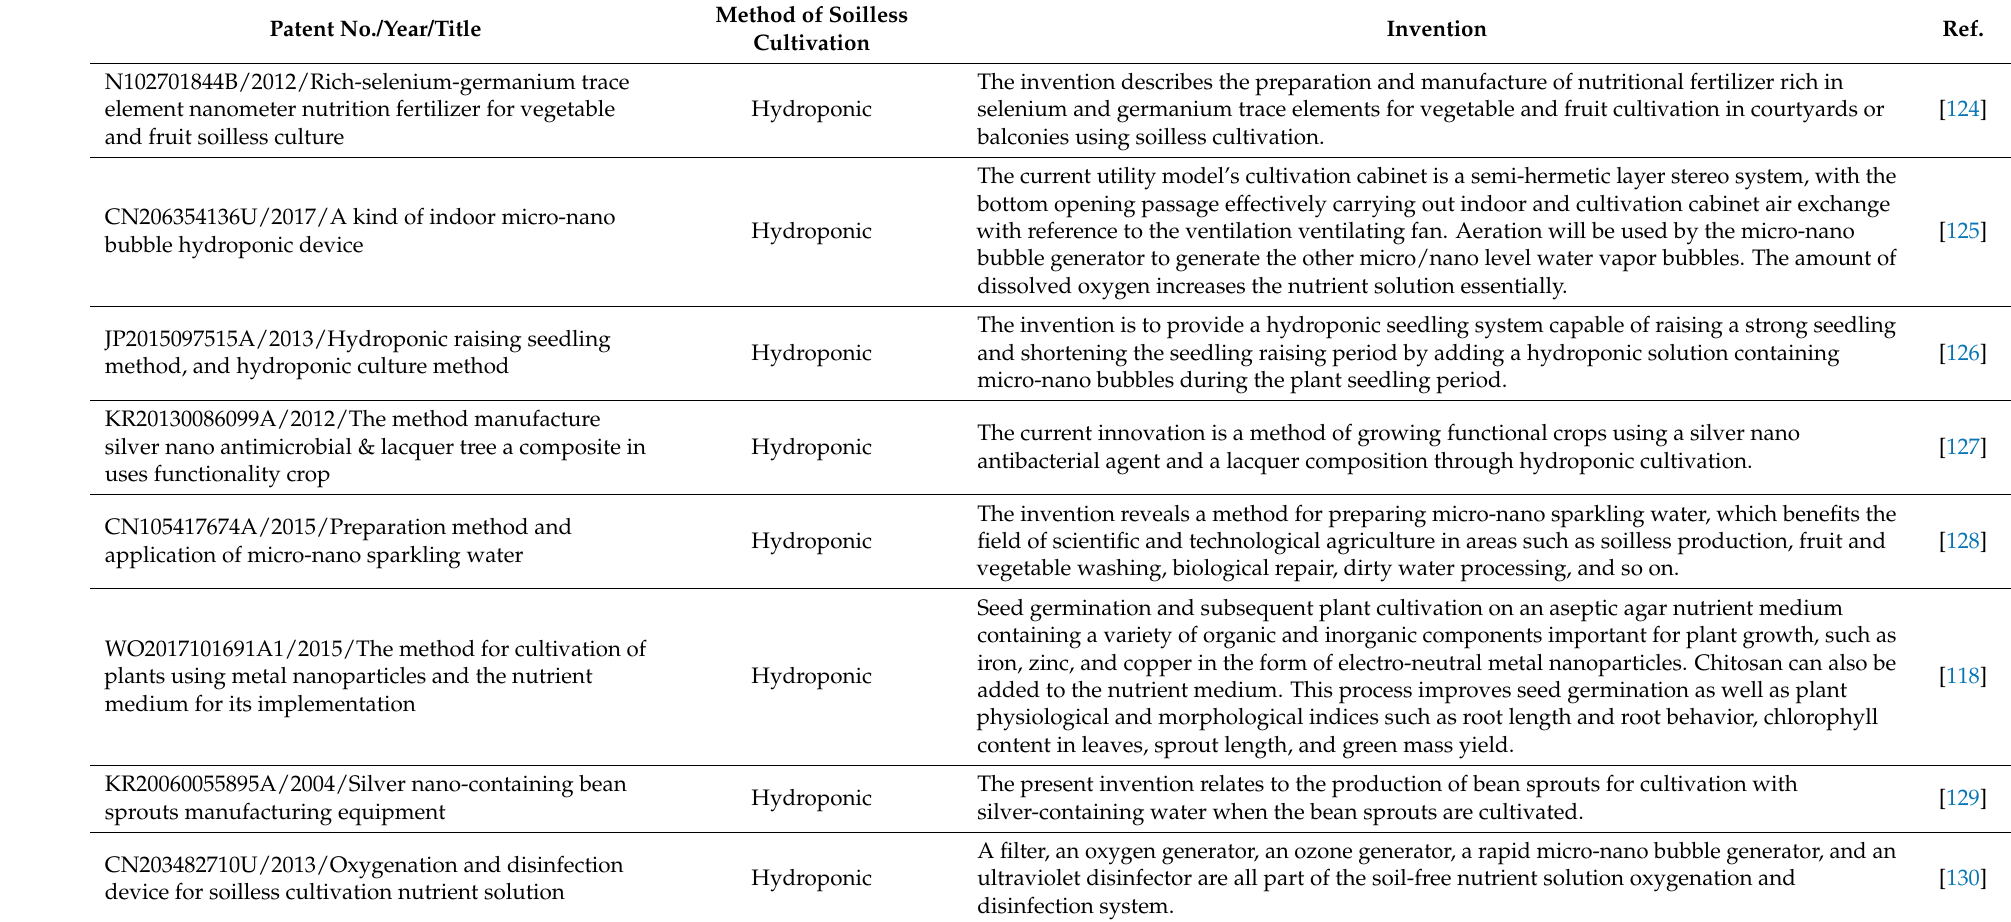
Table 5. Some of the recent patent on nanotechnology approaches in aerated soilless